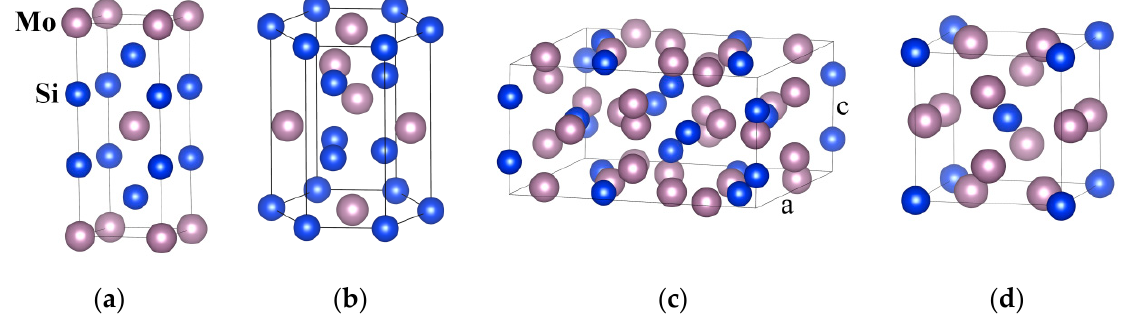
Figure 3. Crystal structure of the Mo-Si intermetallic compounds: ( a ) MoSi2 C11b type; ref. [33]; ( b ) MoSi2 C40 type; ref. [34]; ( c ) Mo5Si3; ref. [35]; ( d ) Mo3Si [36].